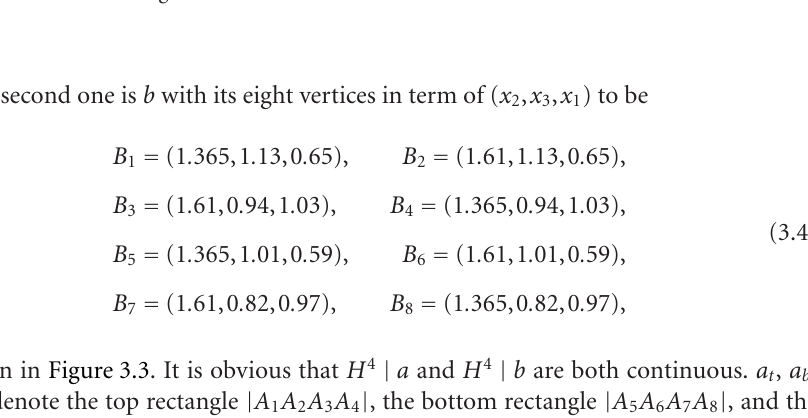
Figure 3.3. The location of cuboid a and cuboid b